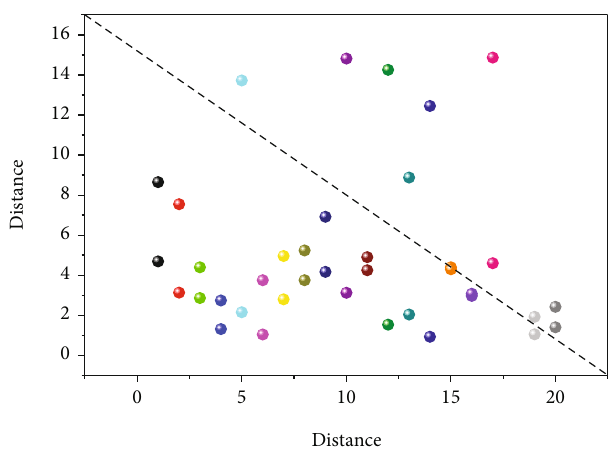
Figure 5: Multiple linear regression